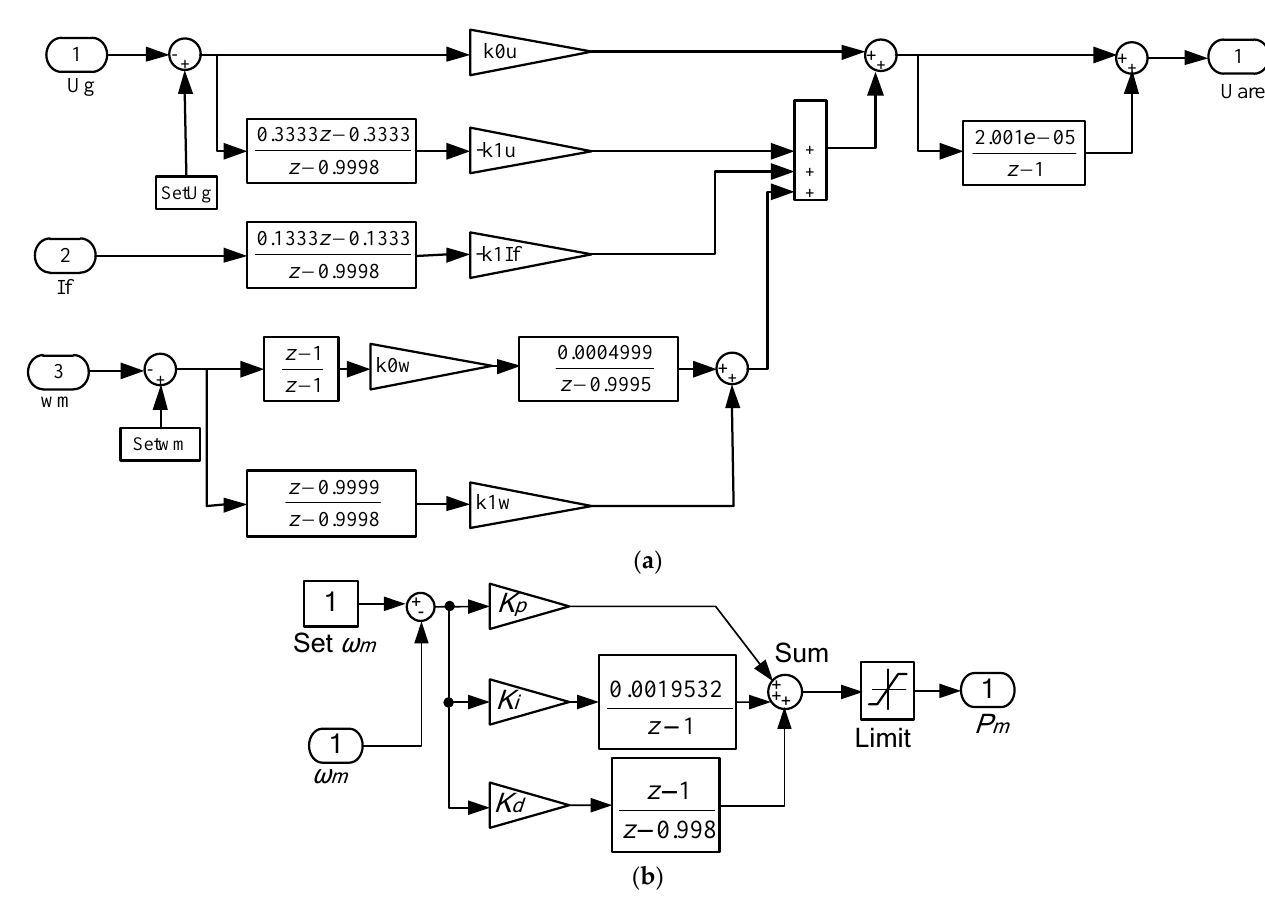
Figure 5. Schematic ( a ) and photo ( b ) of the experimental setup: SS — RPM sensor; T — turbine; SM — synchronous machine; FW — field winding; VT — voltage transformer; CB — circuit breaker. Regulation of generator speed and voltage was carried out on the basis of digital PID controllers, the block diagrams of which are shown in Figure 6.